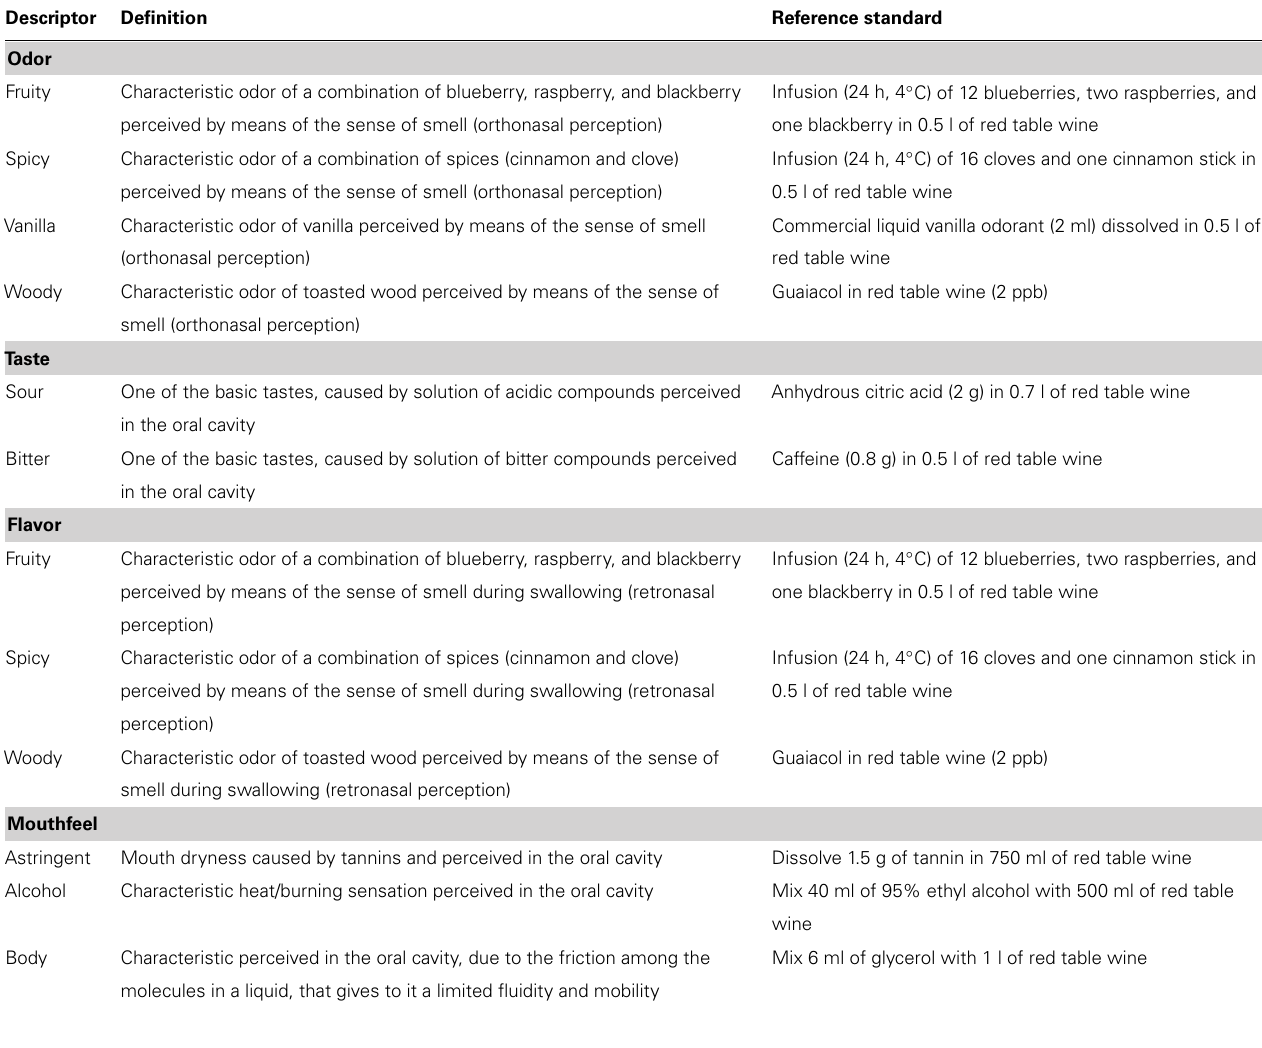
Guaiacol in red table wine (2